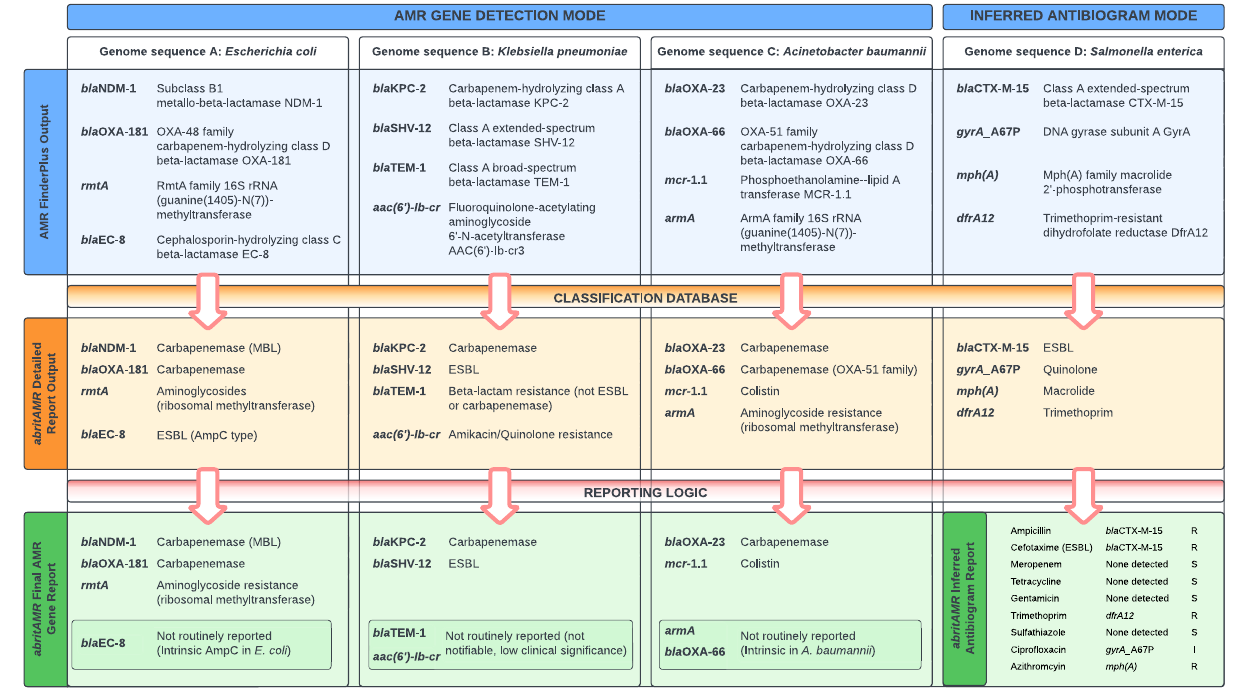
Fig. 2 | Examples of abritAMR pipeline outputs. This fi gure demonstrates abri- tAMR features and outputs across four different species (genome sequence A, Escherichia coli; genome sequence B, Klebsiella pneumoniae; genome sequence C, Acinetobacter baumannii ; genome D, Salmonella enterica) . The horizontal lanes represent the different output stages: top lane, raw AMRFinderPlus output; middle lane, abritAMR Detailed Report output (aligned to and binned by Enhanced Sub- class from abritAMR ’ s classi fi cation database); bottom lane, abritAMR ’ s Final AMR Gene Report (genomes A-C) after application of tailored reporting logic to meet local requirements, and Inferred Antibiogram Report (genome D), currently vali- dated for Salmonella spp. Key features include: (i) simpli fi cation of mechanism or drugclassbins,(ii)identi fi cationandseparationofhigh-priorityAMRgroups(such